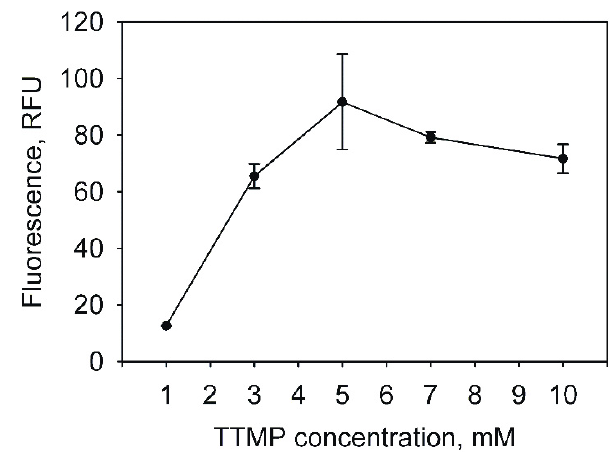
Figure 1. The dependence of the enhanced green fluorescent protein (EGFP) expression in Rhodococcus jostii TMP1 on the concentration of tetramethylpyrazine (TTMP). The EGFP fluorescence was measured by a plate reader ( λ ex = 485 nm; λ em = 510 nm); the data are presented as averages of triplicate measurements with error bars.